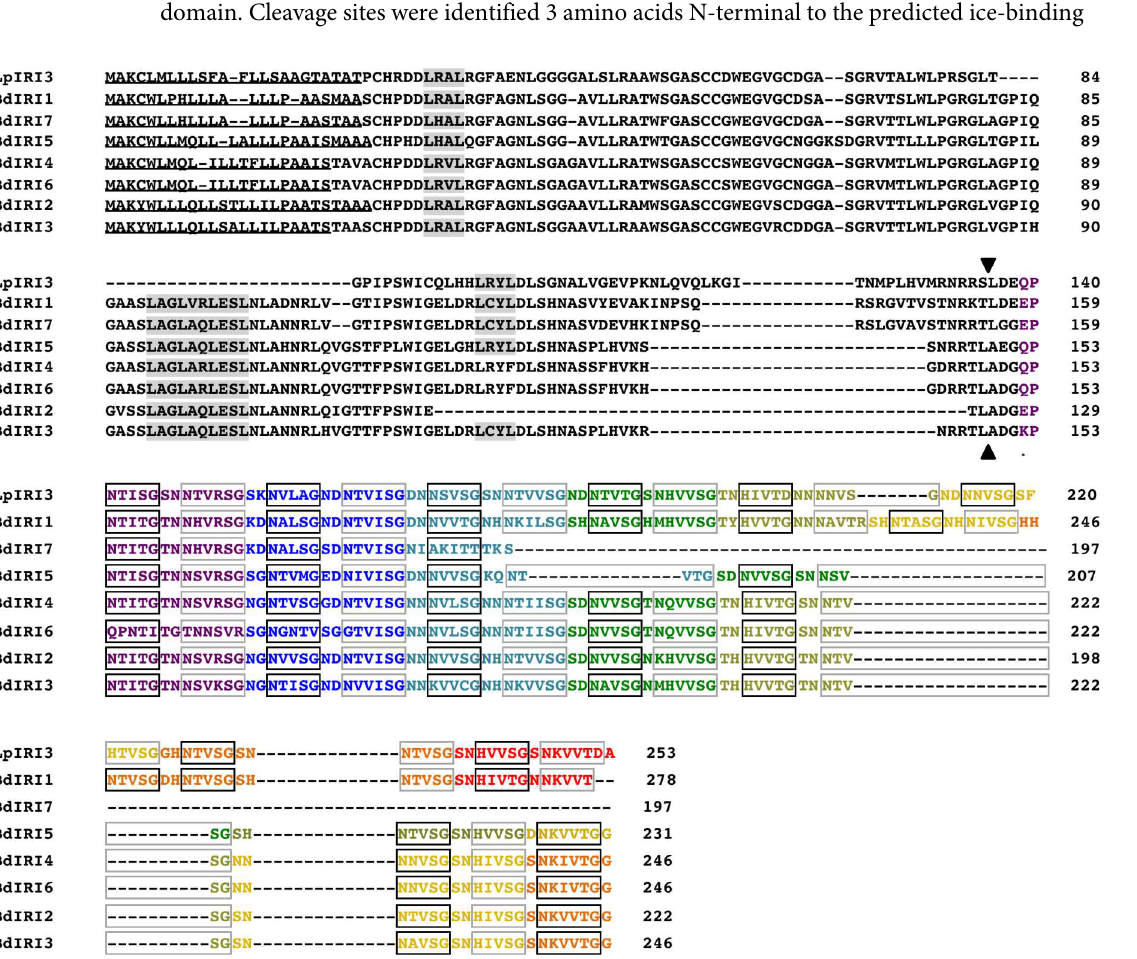
Fig 1. Amino acid sequence alignment of Bd IRI proteins. The Bd IRI amino acid sequenceswere alignedagainst the sequencesof three L . perenne IRI isoforms: Lp IRI4 (EU680851), Lp IRI1 (EU680848), and Lp IRI3 (EU680850),using ClustalW2 multiple sequencealignment tool. N-terminal signal peptides, predicted by the SignalP4.1 server, are underlined. Conserved leucine-richrepeat motifs (LXXL, where x representsa non-conserved residue)are highlightedin grey. The ice-bindingmotifs NXVXG and NXVXXG are outlinedin black and grey boxes, respectively. The amino acids predicted to compose one β -helical turn, as indicatedby the Phyre2 algorithmare presentedas different colors. A black arrow marks the locationof potential cleavagesites in the alignedresidues (see text). Individual columns of residuesare annotated as: ( * ) denoting a single, fully conservedreside; (:) denotingconservation betweengroupsof highly similar properties(scoring > 0.5 in the Gonnet PAM 250 score), and (.) denotingconservation betweengroups of weakly similar properties(scoring= < 0.5 in the Gonnet PAM 250